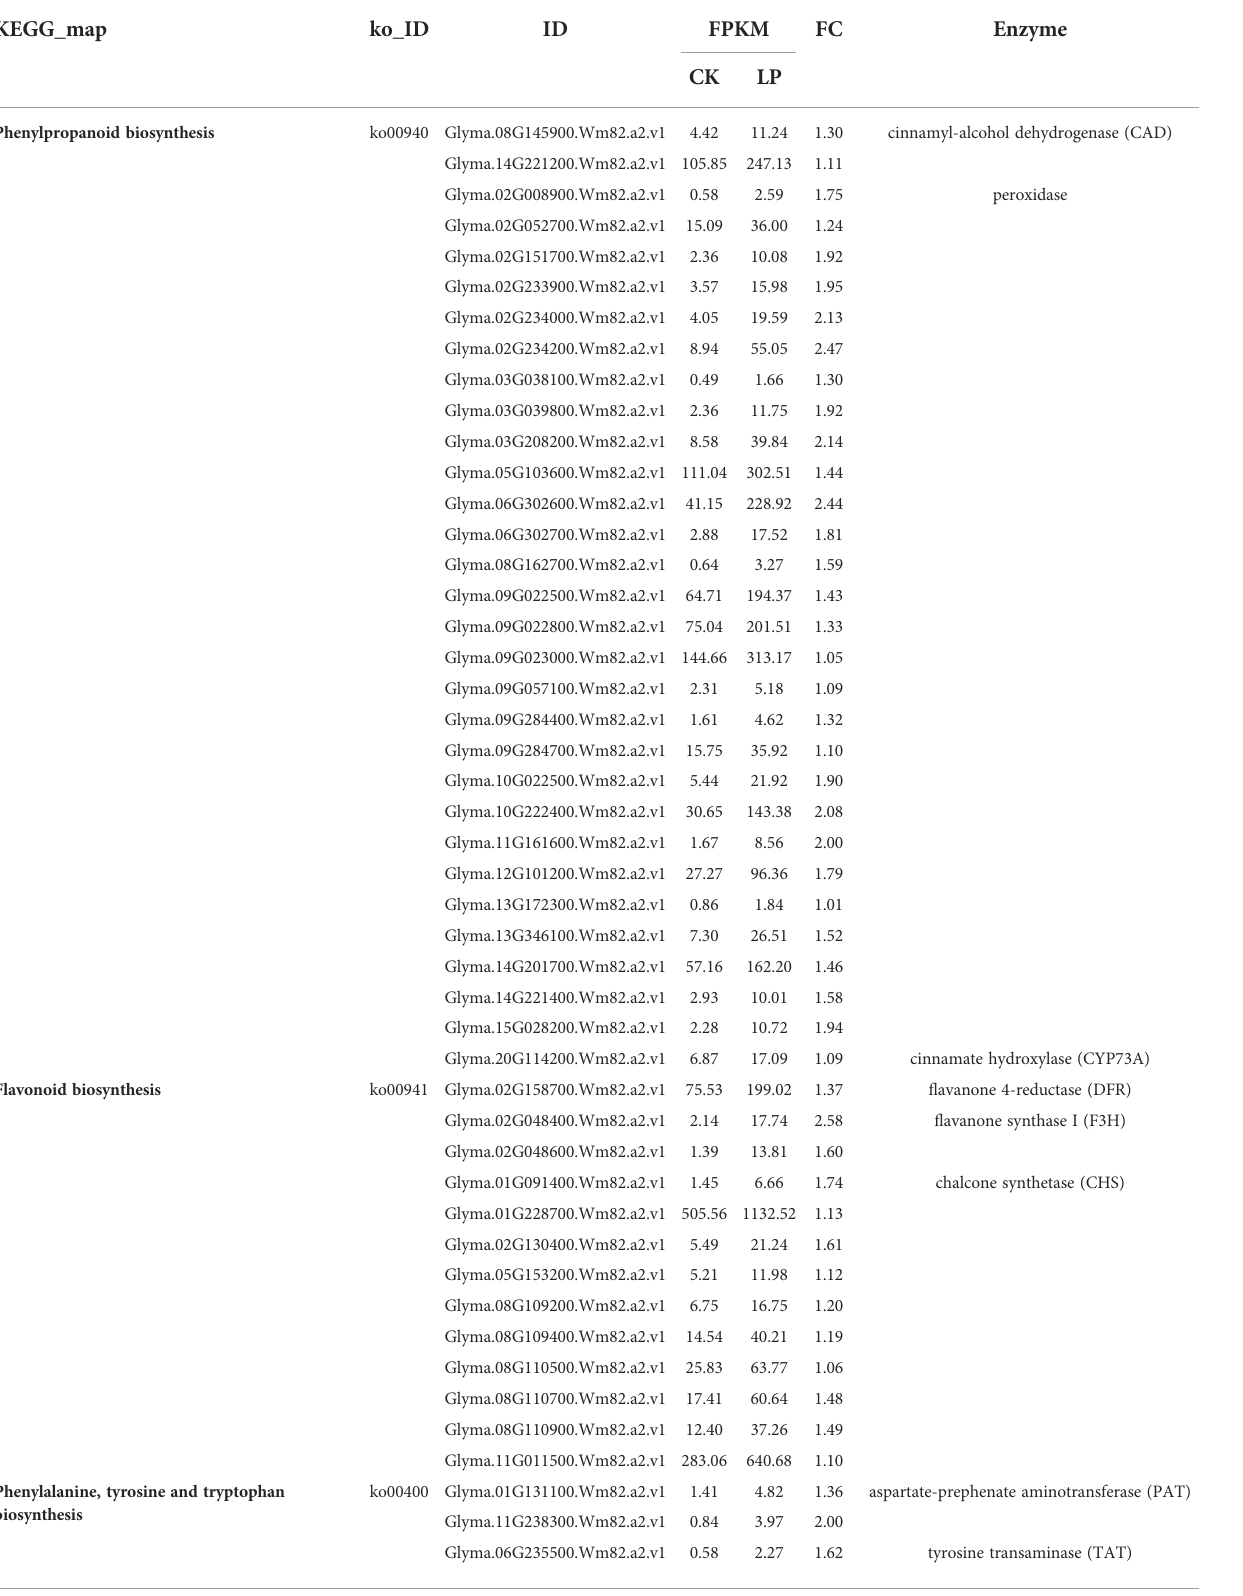
TABLE 4 KEGG pathway of DEGs in roots of barren-tolerant wild soybean seedlings under